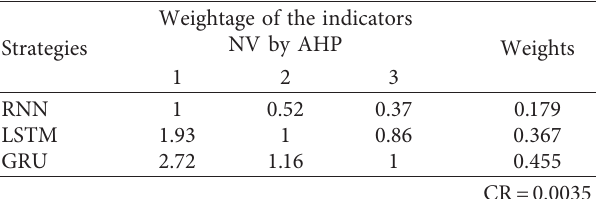
Table 16: Weightage of the indicator NE by AHP on prediction models. Weightage of the indicators Strategies